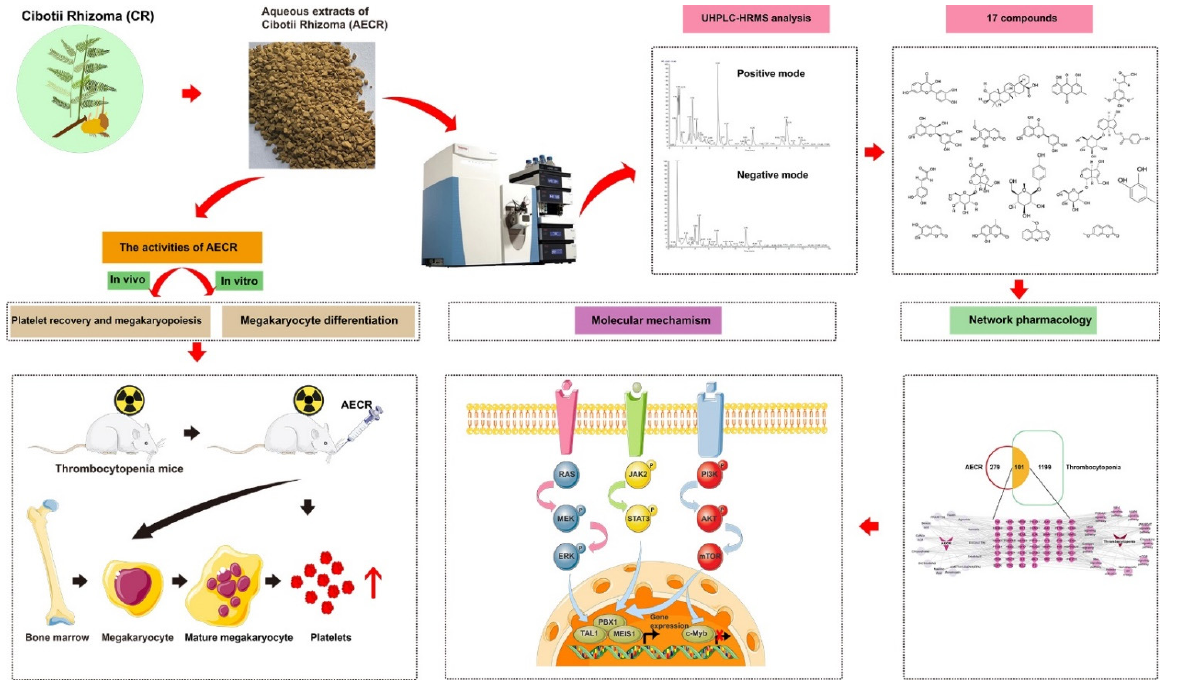
Figure 9. Rhizoma cibotii (RC) promotes megakaryopoiesis and thrombopoiesis through PI3K/AKT, MEK/ERK, and JAK2/STAT3 signaling pathways.